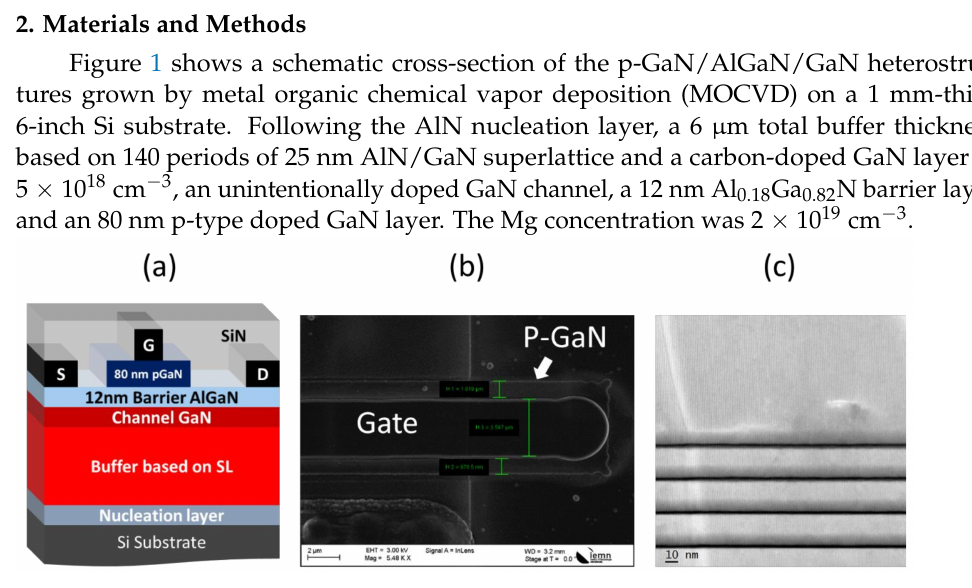
Figure 1. ( a ) Schematic cross section of the p-GaN/AlGaN/GaN HEMT on Si. ( b ) SEM top view of the gate including the partially etched p-GaN layer and ( c ) a zoomed TEM image of the superlattices.